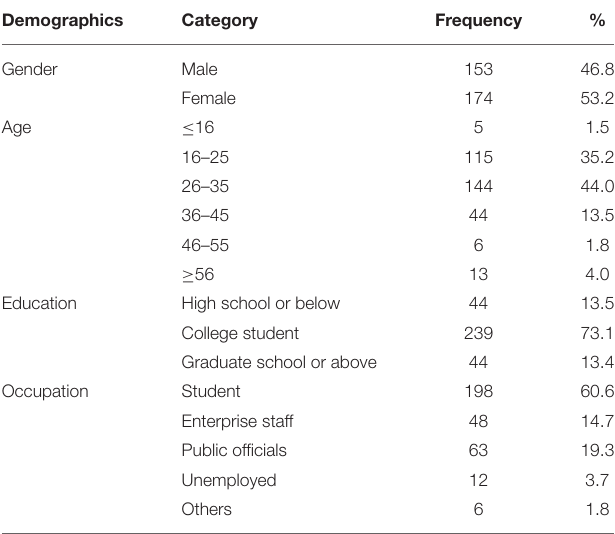
TABLE 1 | Demographics of the survey respondents ( N =